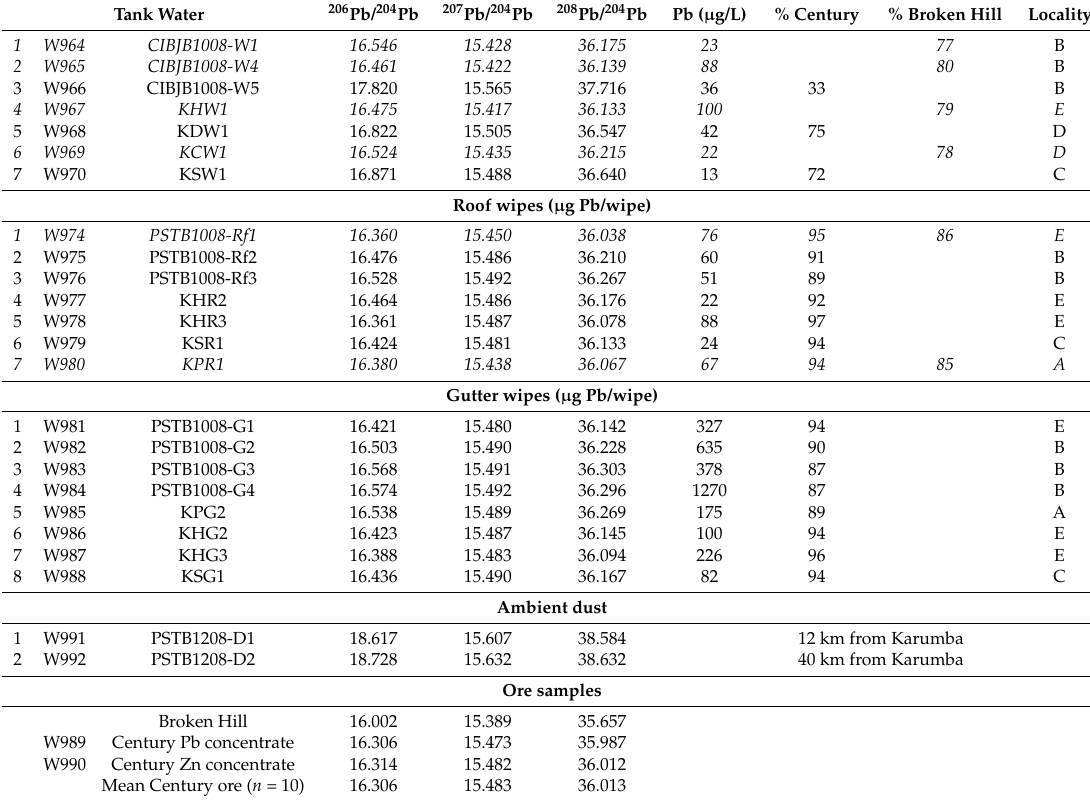
Table 4. Lead isotopic compositions and Pb contents for